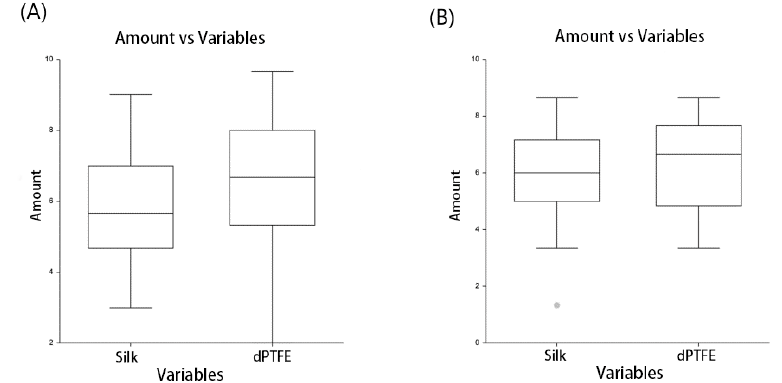
Figure 2. Mean and confidence interval of pocket depth (PD) reduction for both groups. ( A ) Mean and confidence interval for three months after surgery. The PD reduction in the silk mat group was not inferior to that of the dPTFE group ( p non-inferiority < 0.001). ( B ) Mean and confidence interval for six months after surgery. The PD reduction in the silk mat group was not inferior to that of the dPTFE group ( p non-inferiority <